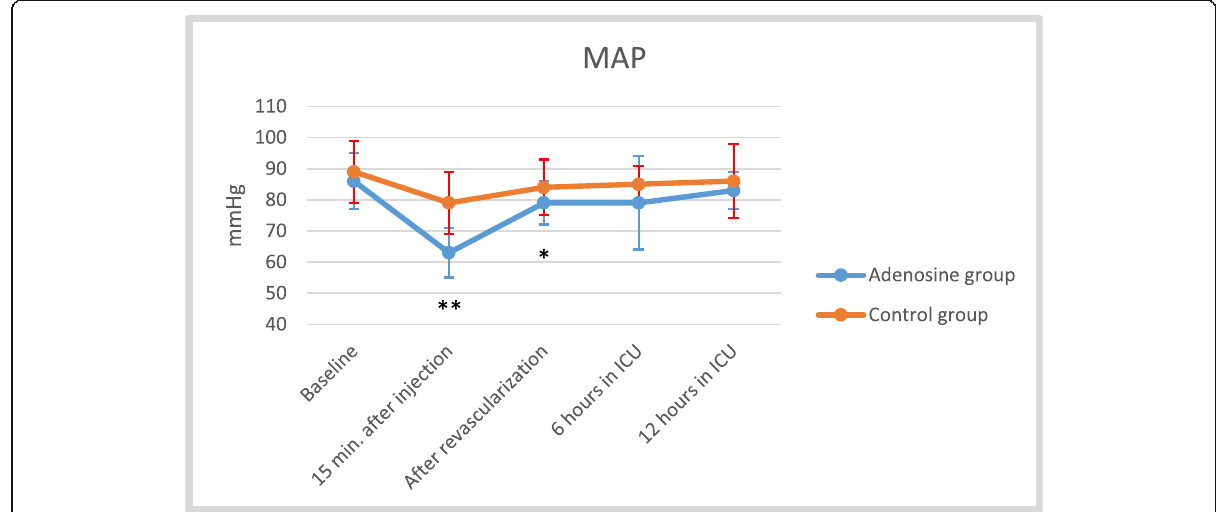
Fig. 2 Effect of adenosine on mean arterial blood pressure (MAP). Data were presented as mean ± SD. ** p value is highly significant. * p value is significant